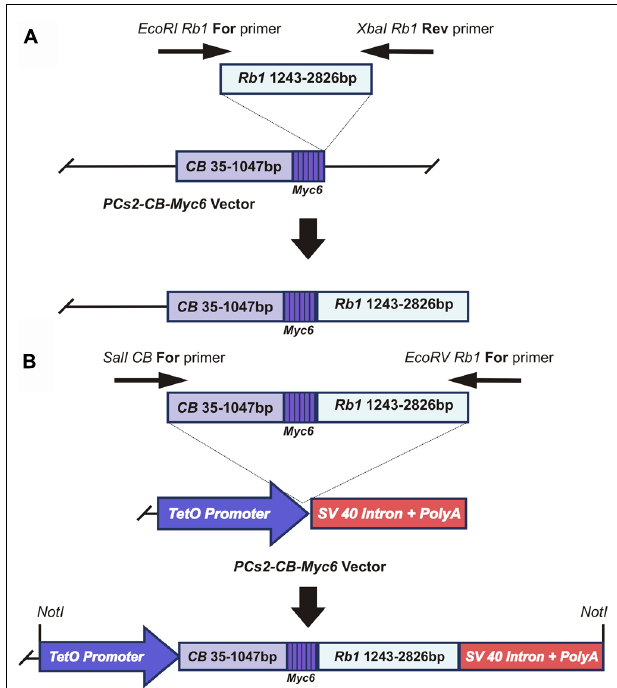
FIGURE 1 | Generation of the CB-Myc6-Rb1 construct. (A) cloning of the Rb1 fragment into the pCS2-CB-Myc6 vector. A 1583bp Rb1 gene product was PCR amplified using Forward and Reverse primers.The resulting Rb1 fragment was cloned between EcoRI and Xbal restriction sites of pCS2 vector containing CB-Myc6 construct (a 1012bp CB gene fragment and a hexameric Myc6 sequence tag), as described previously (Li etal., 1996, 2000). (B) The CB-Myc6-Rb1 fragment was cloned into the pTetSplice vector between the SalI and EcoRV restriction sites.